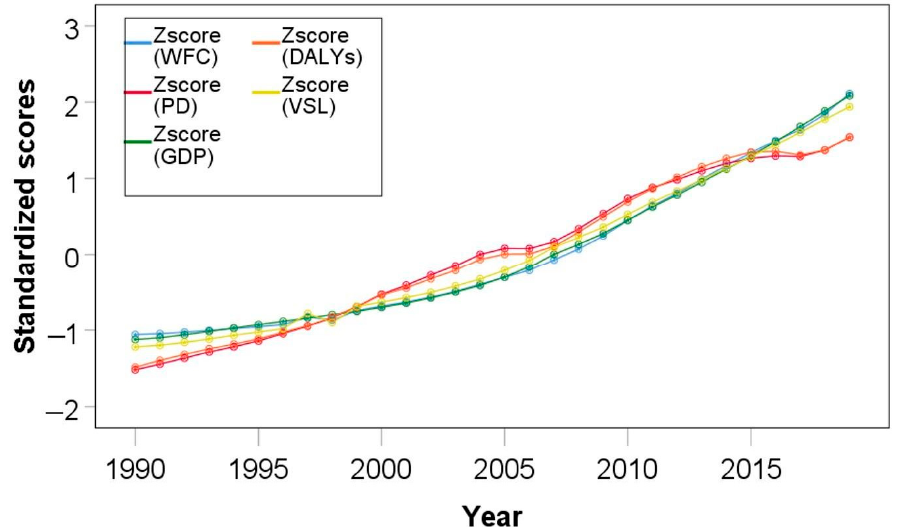
Figure 11. GDP growth in China and simultaneous increases in premature deaths (PD), disability- adjusted life years (DALYs), welfare costs of premature deaths (WFC) and value of a statistical life (VSL), as attributed to exposure to PM 2.5 , from 1990 to 2019. (Original data source: OECD Stat.).